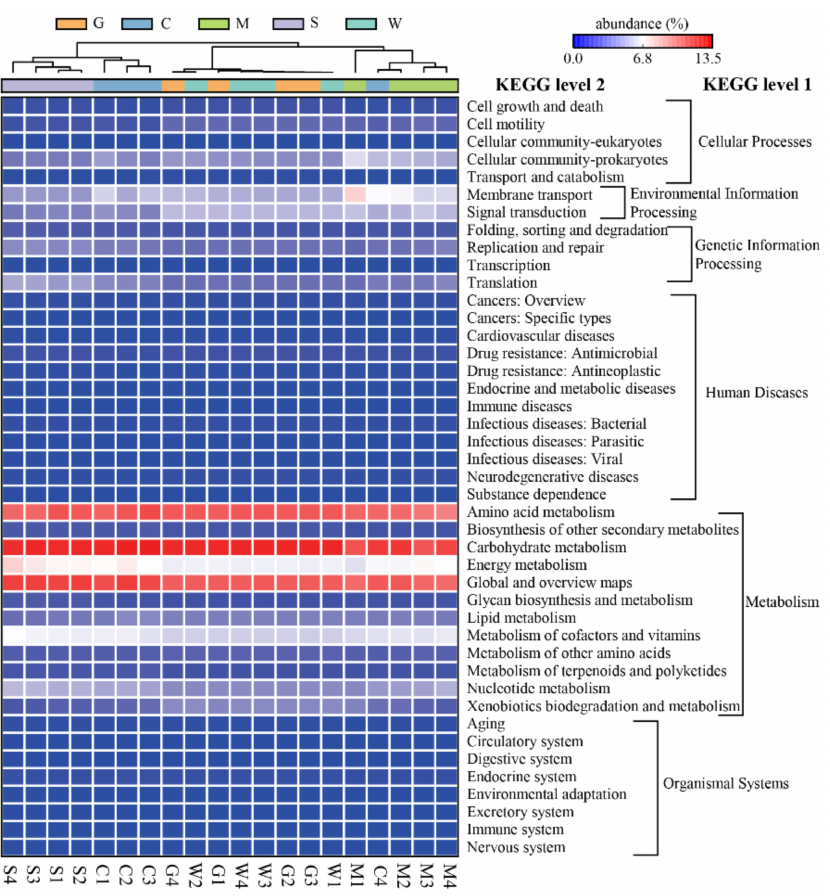
Figure 8. Heatmap profiles showing the functional categories (Kyoto Encyclopedia of Genes and Genomes (KEGG) level 1 and level 2) of the bacterial communities, as predicted by the Phyloge- netic Investigation of Communities by Reconstruction of Unobserved States (PICRUSt2) analysis. The functional clustering analysis is based on the unweighted pair-group method with arithmetic means (UPGMA). Rows represent the KEGG Orthology (KO) functions, columns represent the 20 samples, and the color intensity in the heatmap represents the relative abundance (%) of the func- tional categories. G: gill mucosae (G1–G4); C: intestinal contents (C1–C4); M: intestinal mucosae (M1–M4); S: stomach contents (S1–S4); W: stomach mucosae